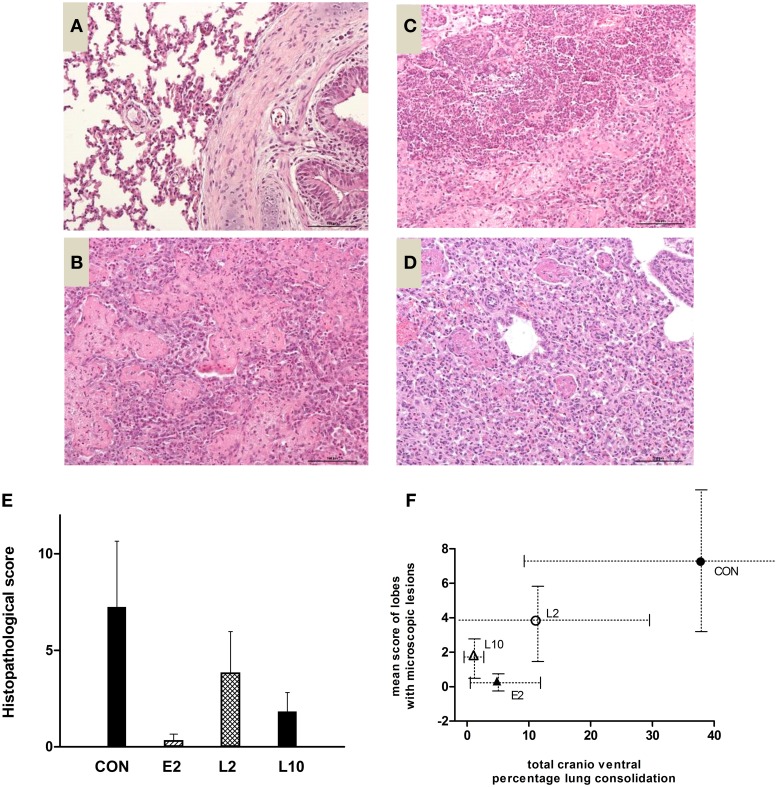
Microscopic examination. (A) Normal lung microscopic examination (hemalun and eosin, x200). (B) Lesions of hemorrhagic alveolitis, large fibrinous deposits, and major infiltration of leucocytes, score of 2 (hemalun and eosin, × 200). (C) oat cells and altered neutrophils, score of 2 (hemalun and eosin, × 200). (D) Macrophagic alveolitis, score of 1 (hemalun and eosin, × 200). (E) Mean histopathological score (+∕− sd) of calves challenged with M. haemolytica and treated with 2 or 10 mg/kg marbofloxacin at the early or late stages of infection. (F) Correlation between the total cranioventral percentage of lobe consolidation (gross lesions, × axis) and number of lobes with microscopic lesions (y-axis).